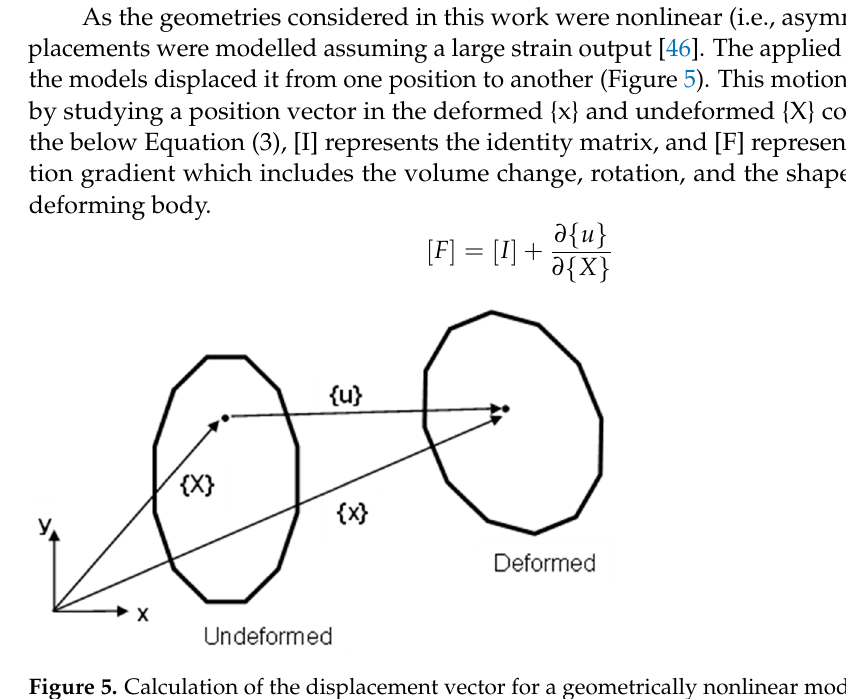
Figure 4. Calculation of the displacement vector for a symmetric model.